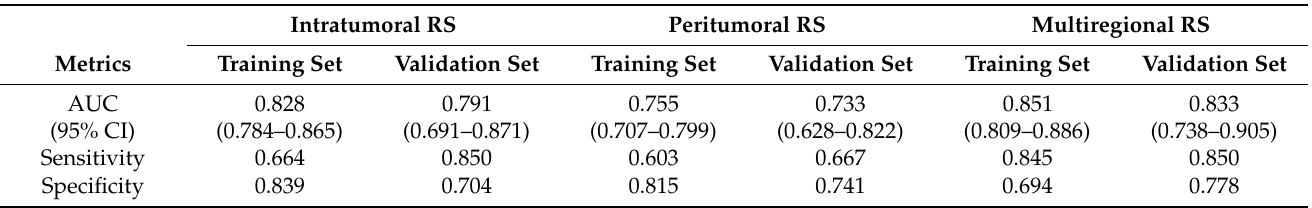
Figure 3. The receiver operator characteristic curves of the intratumoral RS ( a ), the peritumoral RS ( b ), and the multiregional RS ( c ) for predicting estrogen receptor status in the training and validation sets. Table 2. Diagnostic performances of three RSs for predicting the estrogen receptor status in the training and validation sets.